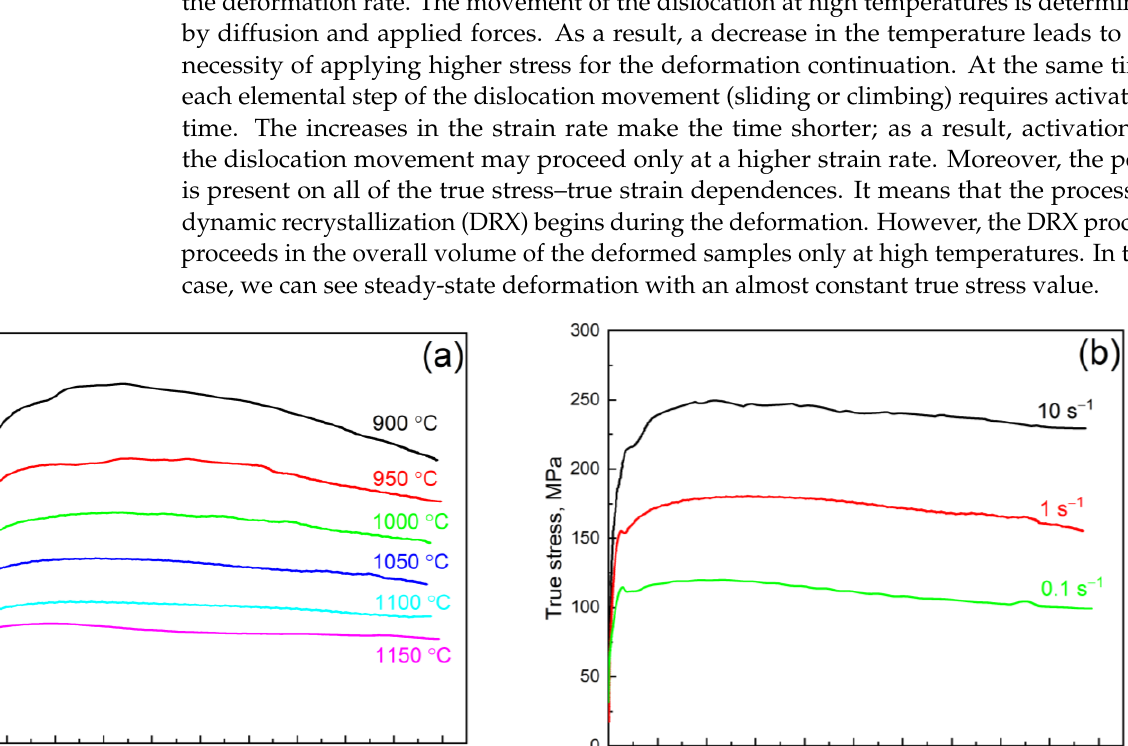
Figure 4. The calculated phase composition at high temperatures of the investigated steel.